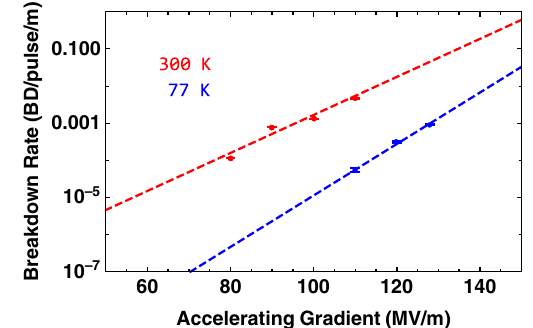
FIG. 9. The collected breakdown rates with the fitted slope of the distributed-coupling accelerator structure at 300 and 77 K. The breakdown rates at 300 K are obtained from our previous testing of the same accelerator structure at room temperature. For both operating temperatures, the data were collected for a 400 ns stepped pulse with a flat gradient of 200 ns. The results show a reduction by 2 orders of magnitude, × 1 , in breakdown rates at 100 the same gradient levels from 300 to 77 K